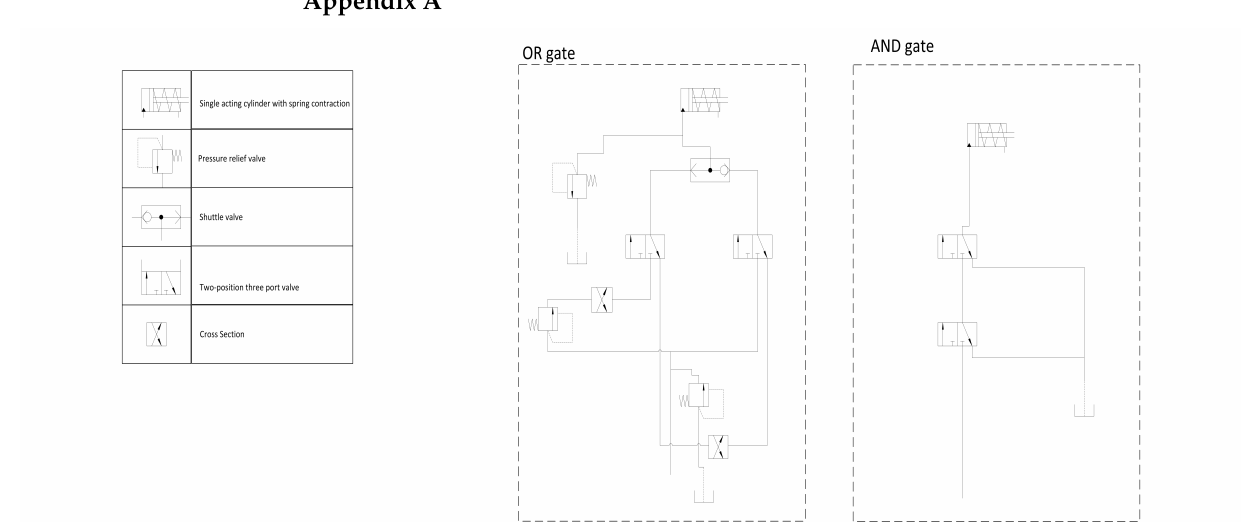
Figure A1. Logic gates and their respective hydraulic